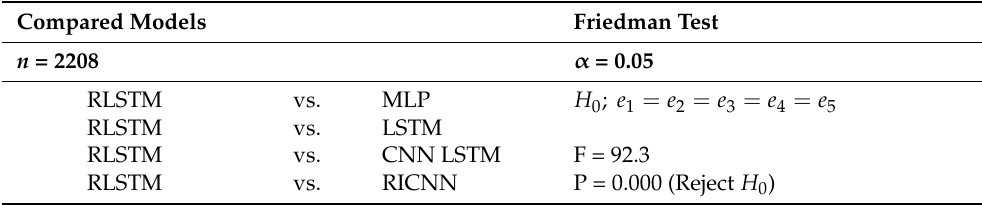
Table 9. Friedman test results for performance of next-day electricity demand. Compared Models